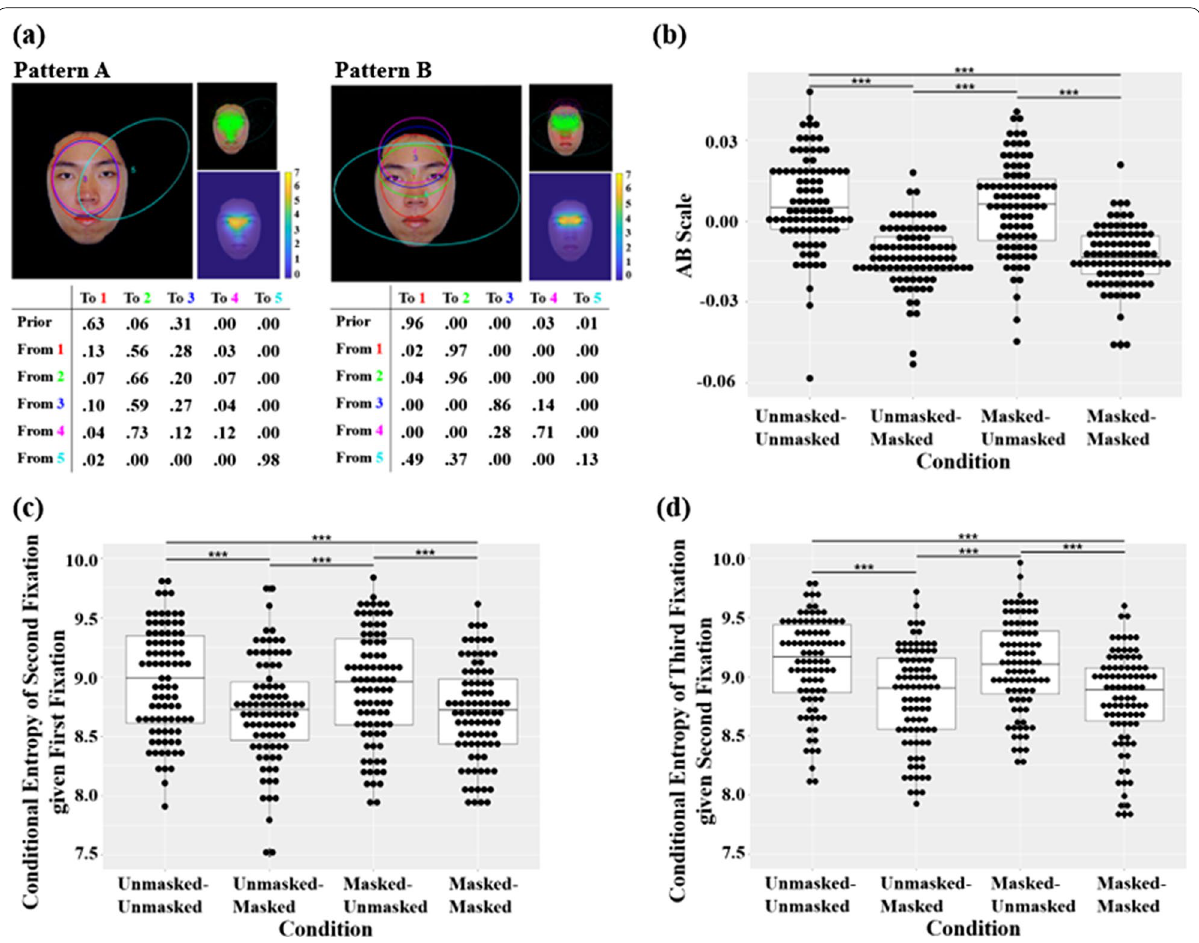
Fig. 3 Eye movement data during the recognition phase. a The two representative eye movement patterns discovered using EMHMM during face recognition: In each pattern, the ellipses show ROIs as 2‑D Gaussian emissions. Priors in the table show the probabilities that a fixation sequence starts from the ellipse. The table also shows transition probabilities among the ROIs. The smaller image on the top‑right shows the assignment of actual fixations to different ROIs. The assignment of fixations to the ROIs was based on the ROI sequence with the largest posterior probability given the fixation sequence. The smaller image on the bottom‑right shows the corresponding heatmap. Note that ROI 5 (Cyan) in both patterns captures outlier fixations that do not belong to other ROIs. b Eye movement pattern measured in A – B scale in different mask conditions. c Eye gaze transition consistency from the first fixation to the second fixation as measured in conditional entropy. d Eye gaze transition consistency from the